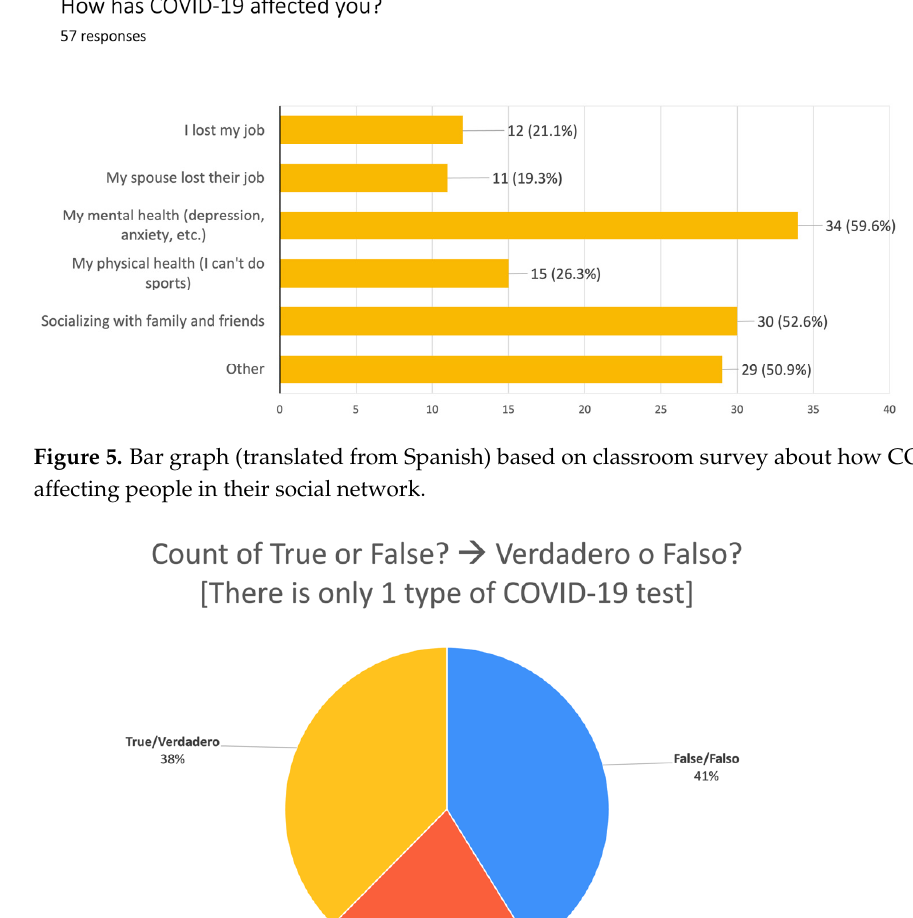
Figure 4. Depiction of a learner’s social network as emanating from herself at the center, even as each name reveals they do not live nearby. Names have been changed to preserve confidentiality.